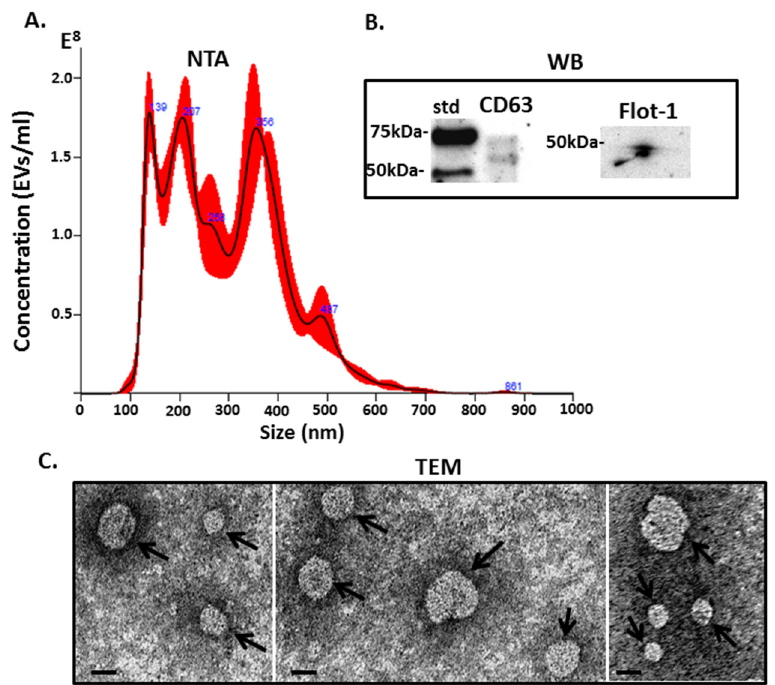
Figure 1. Halibut serum-extracellular vesicles (EV)s were characterised by: ( A ) Nanoparticle tracking analysis (NTA), showing size distribution profiles of EVs in the size range of 50–600 nm, with the modal size of vesicles at 138 nm; ( B ) Western blotting (WB) analysis shows that the EVs are positive for CD63 and Flotillin-1; ( C ) Transmission electron microscopy (TEM) showing EV morphology—see arrows pointing at EVs (scale bar is indicated at 20 nm).